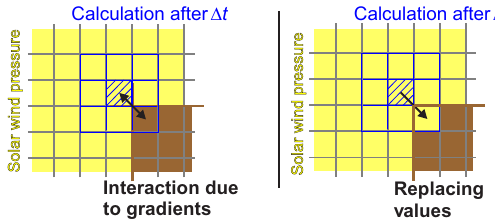
Figure 2. Density and pressure gradients across the planetary sur- face are related to forces if the MHD equations are solved within the entire simulation box. To minimize this interaction, the density and the pressure at the planetary surface are set to the values outside the